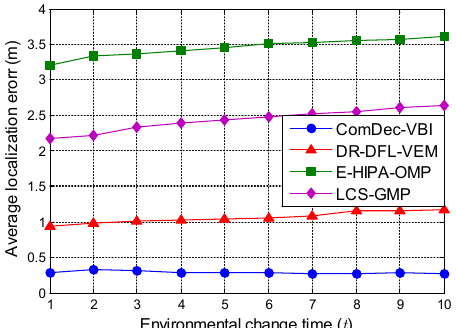
Figure 9. Effect of environmental changes on the average localization error ( Avg . Error ) of multiple DFL approaches.